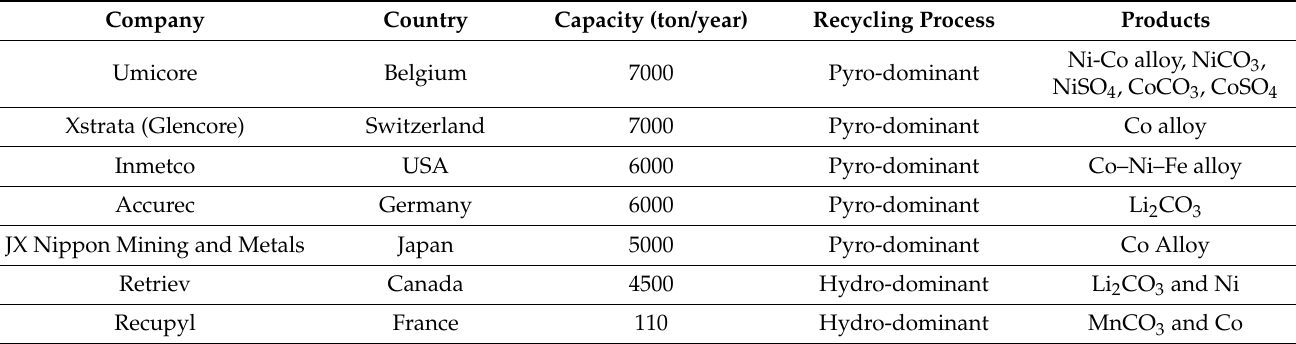
Table 2. Current major commercial processes for recycling spent LIBs